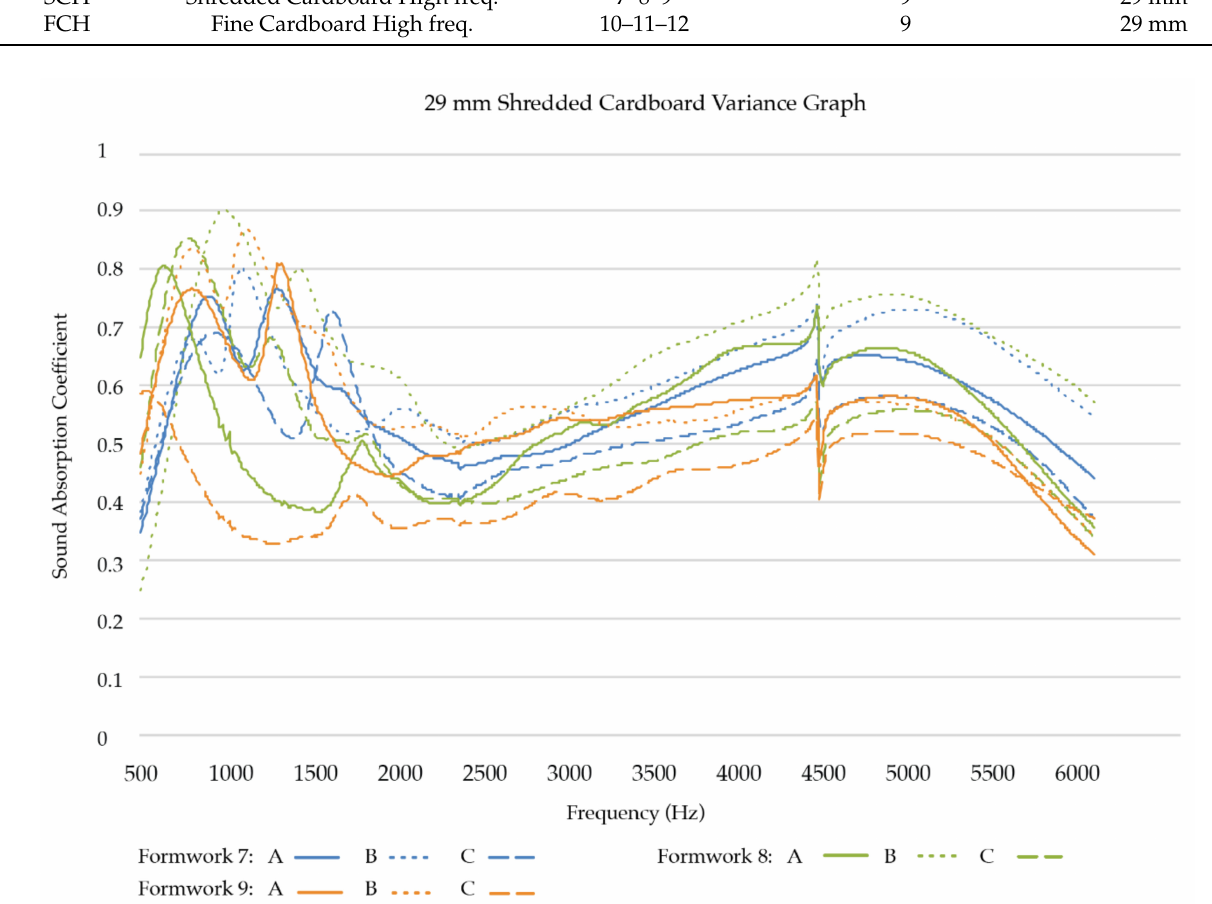
Figure 11. Sound Absorption Coefficients of SCH replicates (29